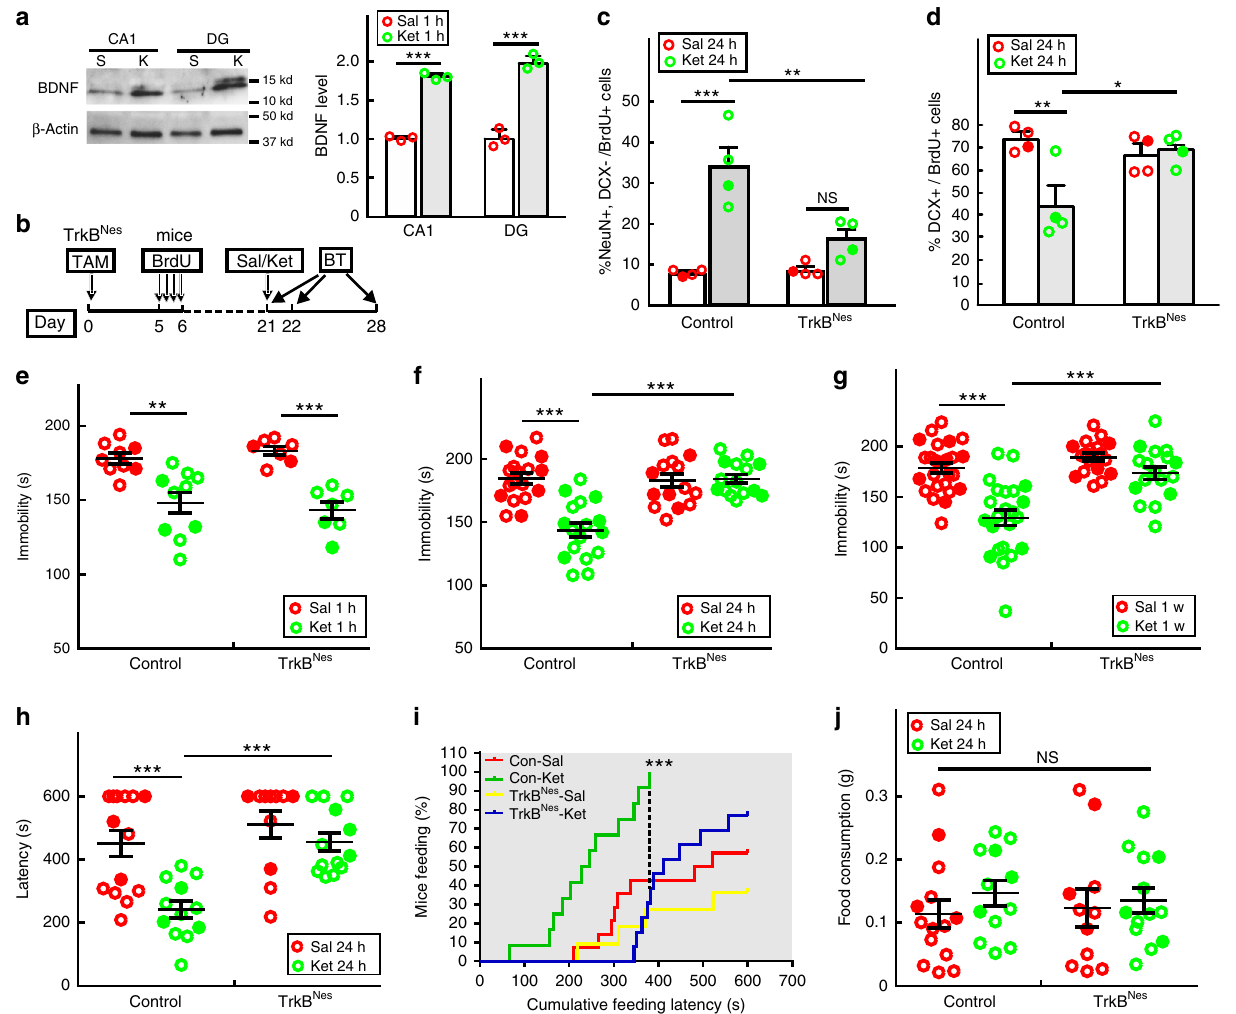
Fig. 5 TrkB is required in adult NPCs to mediate the antidepressant effects of ketamine. a The quanti fi cation on BDNF immunoblots of dissected adult CA1 and DG regions shows the BDNF protein level signi fi cantly increases 1 h after saline (S) or ketamine (K) treatment. ( n = 3; *** p < 0.0001 for CA1, *** p < 0.0001 for DG). b Nestin-creER T2 ; TrkB fl ox/ fl ox (TrkB Nes ) mice were induced with tamoxifen (TAM) three weeks before saline (Sal) or ketamine (Ket) treatment. BrdU pulses were administrated sixteen days before treatment, and mice were given behavior tests (BT) 1 h, 24 h or 1 week after treatment. c The percentage of newborn NeuN+/DCX − neurons in BrdU+ cells (two-way ANOVA, Tukey post hoc, *** p = 0.0001 for saline vs ketamine in control mice; ** p = 0.0031 for ketamine-treated control vs TrkB Nes ; p = 0.2510 for saline vs ketamine in TrkB Nes ). d Percentage of newborn DCX+ cells (two-way ANOVA, Tukey post hoc, ** p = 0.0048 for saline vs ketamine in control; * p = 0.0219 for ketamine treatment in control vs TrkB Nes ). e In the FST, TrkB Nes mice respond to ketamine 1 h after treatment (two-way ANOVA, Tukey post hoc, ** p = 0.0013 for saline vs ketamine in control mice and *** p < 0.001 for saline vs ketamine in TrkB Nes ). However, they do not retain the behavioral response at both ( f ) 24 h (two-way ANOVA, Tukey post hoc, *** p < 0.001